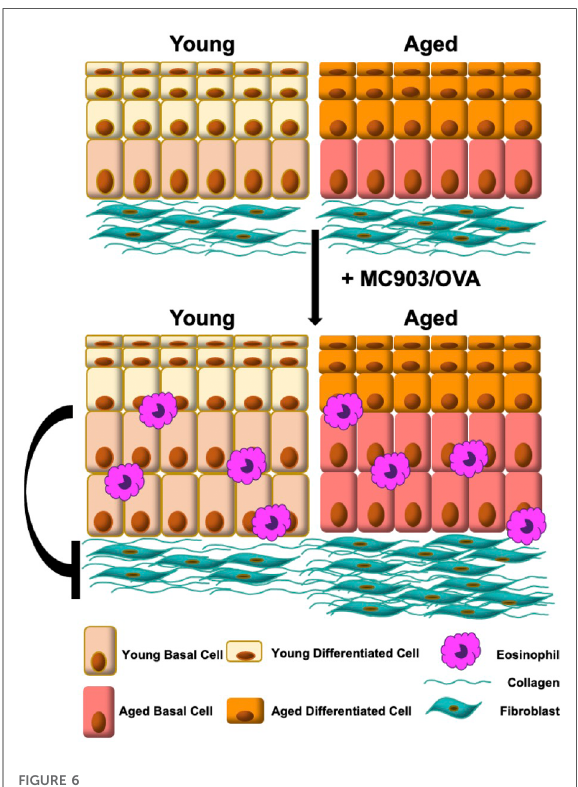
FIGURE 6 Model: signals from young esophageal epithelium limit fi broblast contraction and are diminished upon tissue aging, promoting fi brosis in the presence of eosinophilic esophagitis in fl